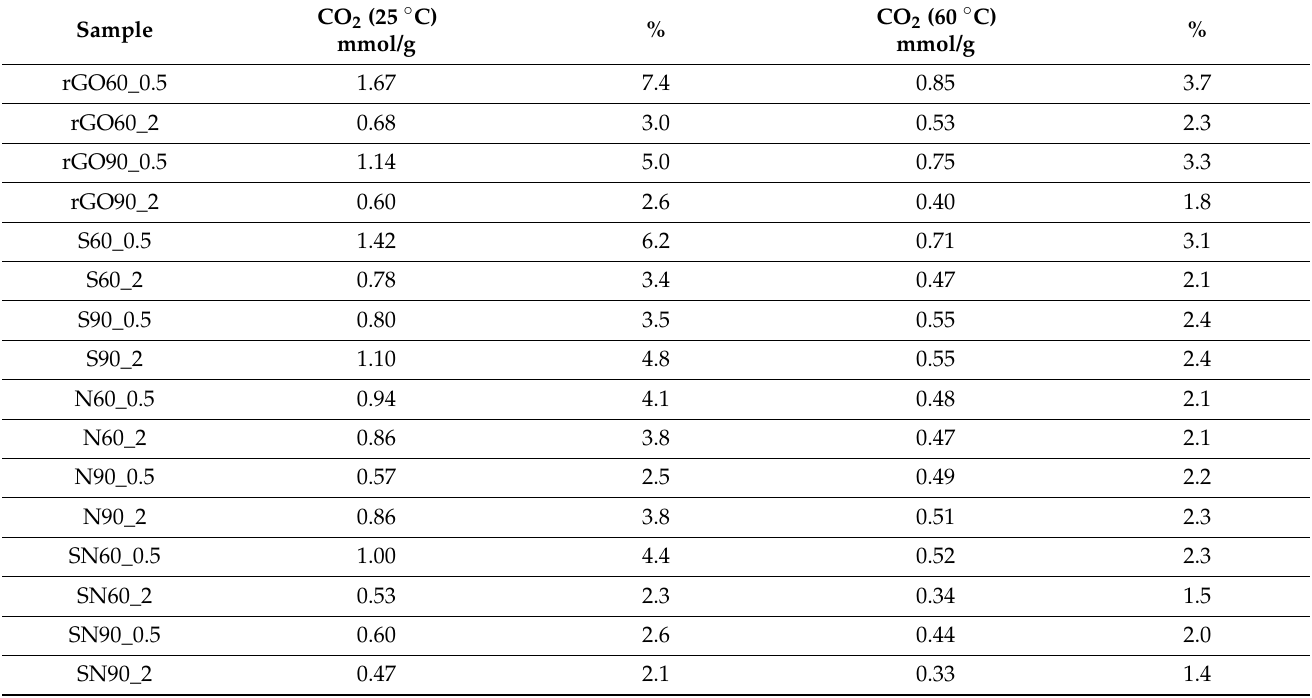
Table 4. CO 2 adsorption of all monoliths at two different temperatures (25 ◦ C and 60 ◦